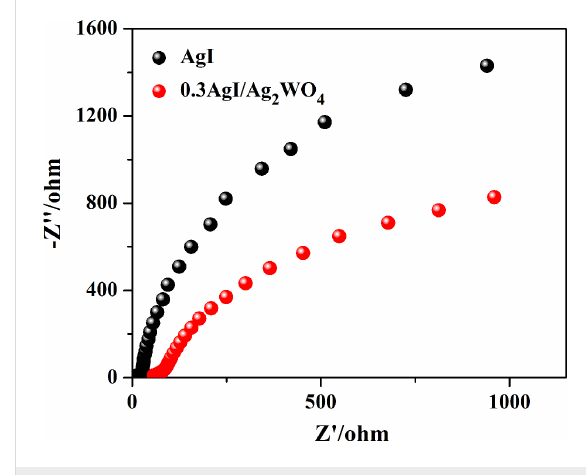
Figure 10: Electrochemical impedance spectroscopy (EIS) Nyquist plots of AgI and 0.3AgI/Ag 2 WO 4